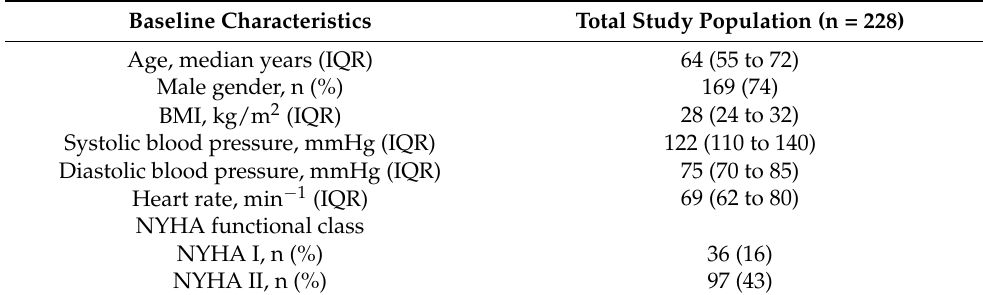
Table 1. Baseline characteristics for the HFrEF cohort. Continuous variables are given as medians and interquartile ranges (IQR), counts are given as numbers and